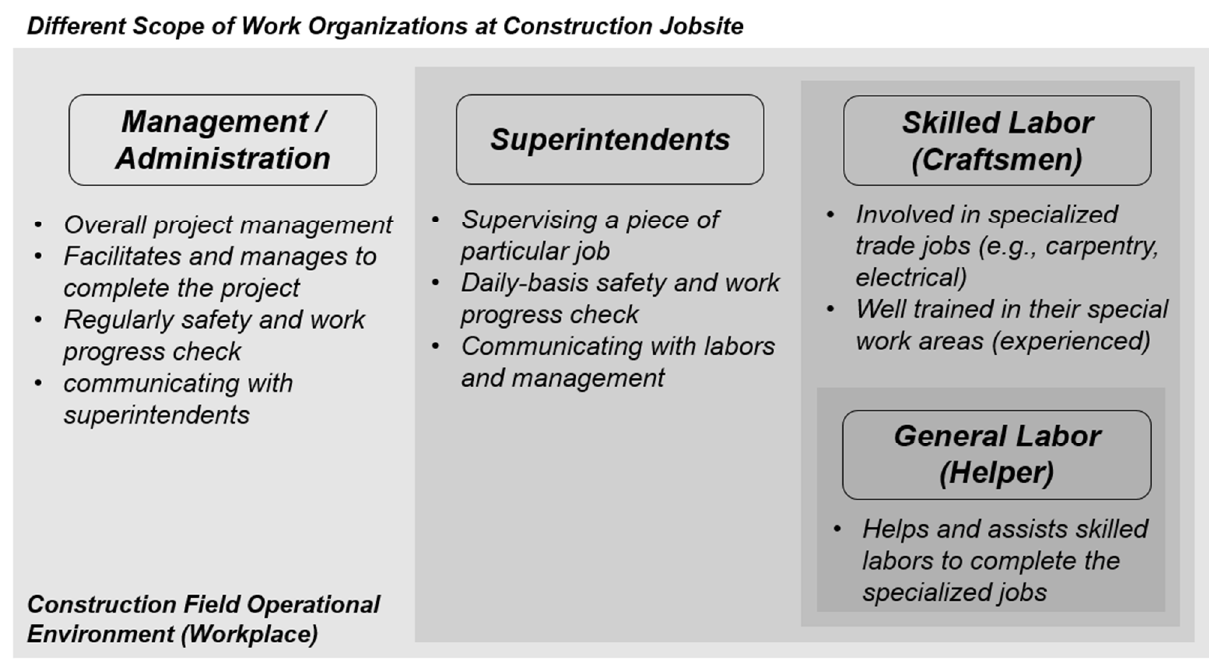
Figure 2. Scope of the different perceptions at the construction worksite.